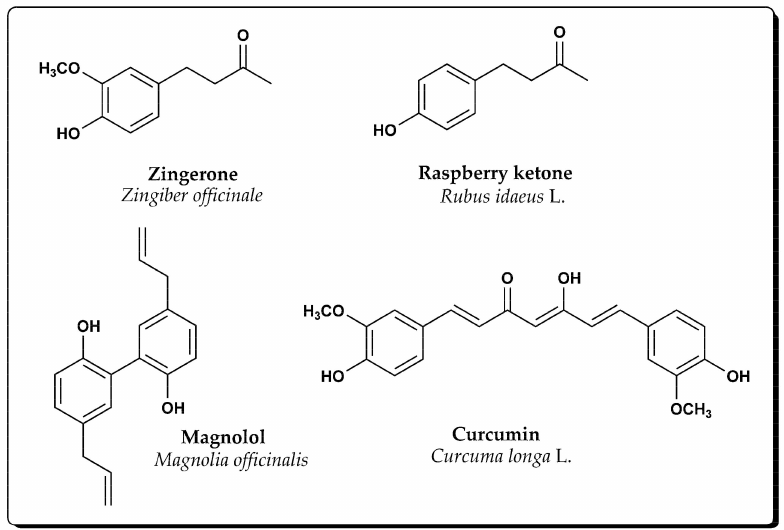
Figure 1. Chemical structures of some natural